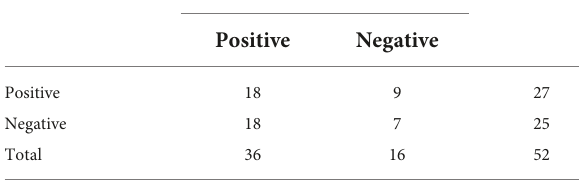
Core needle biopsy MFC for aspiration